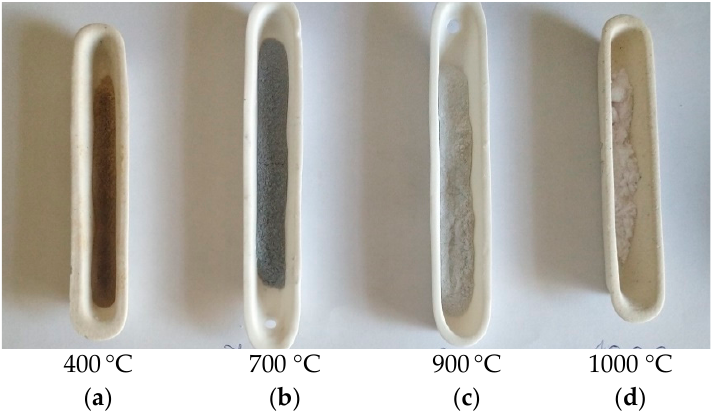
Figure 5. Camera photo of powders after heat treatment at 400 °C ( a ), 700 °C ( b ), 900 °C ( c ), and 1000 °C ( d ). Powders subjected to heat treatment at 400 °C, 700 °C, 900 °C, and 1000 °C had dif- ferent colors (Figure 5). Powder after heat treatment at 400 °C was colored orange-gray. Powder after heat treatment at 700 °C was colored dark gray. Powder after heat treatment at 900 °C was colored light gray, and powder after heat treatment at 1000 °C was colored white. The powder coloring can be explained by the presence of organic components that are thermally degraded to different extents. The greater the organic component degrada- tion, the less coloring there is. The colors of powders heat-treated at 400 °C, 700 °C, 900